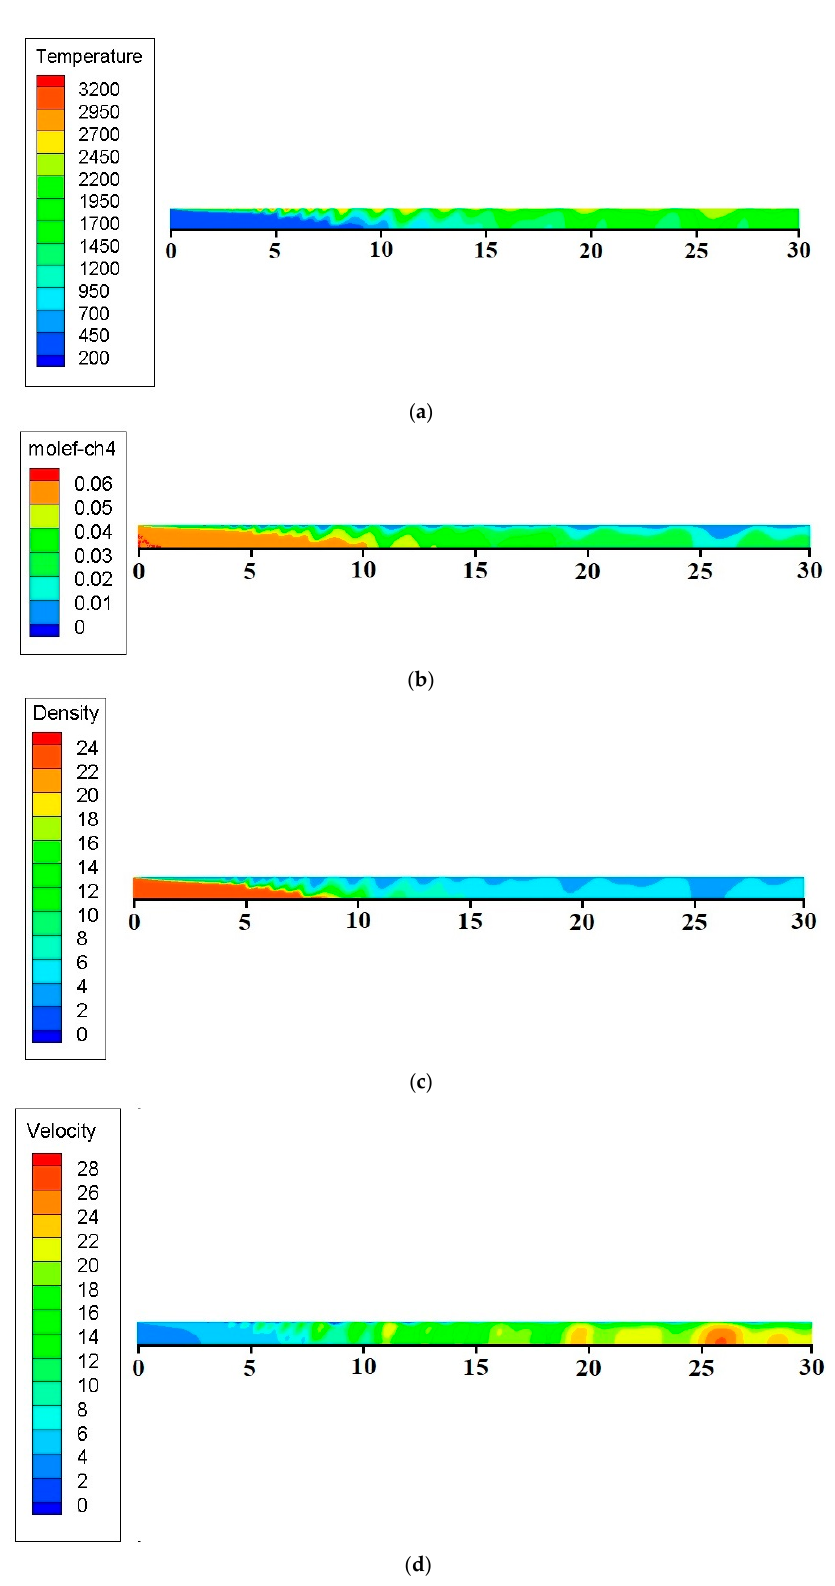
Figure 17. Temperature, concentration, density, and flow velocity distribution at 2 MPa. ( a ) Tem- perature distribution. ( b ) Methane concentration distribution. ( c ) Density distribution. ( d ) Velocity distribution.